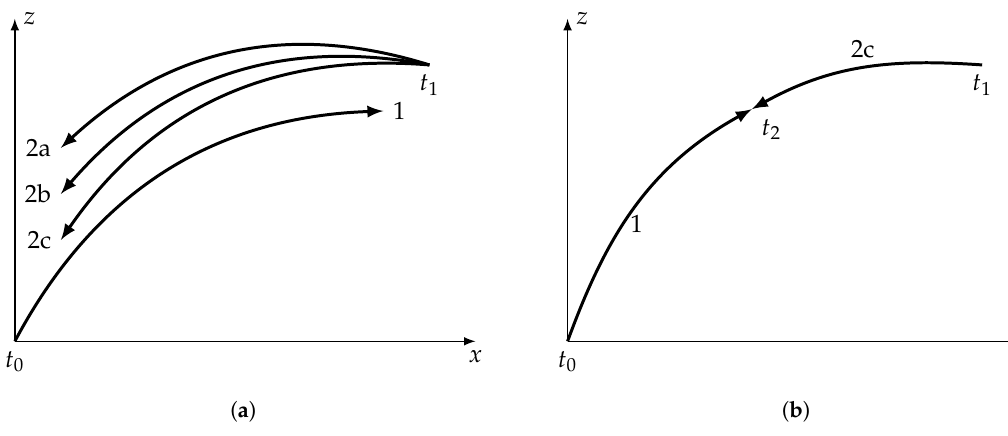
Figure 2. Ascent trajectory 1 from lift-off Equation (41a) and descent trajectories (2a, 2b, 2c) from burn-out Equation (41b) in the two cases when Equation (42), the two-point boundary-value problem (TPBVP), has: ( a ) no solution, and the trajectories do not cross because Equation (42) cannot be satisfied for any matching time t 2 ; ( b ) has at least one solution, because Equation (42) has solutions for matching time t 2 corresponding to the crossing of trajectories. At the matching time the trajectories are tangent because both the horizontal and vertical coordinates and velocities are